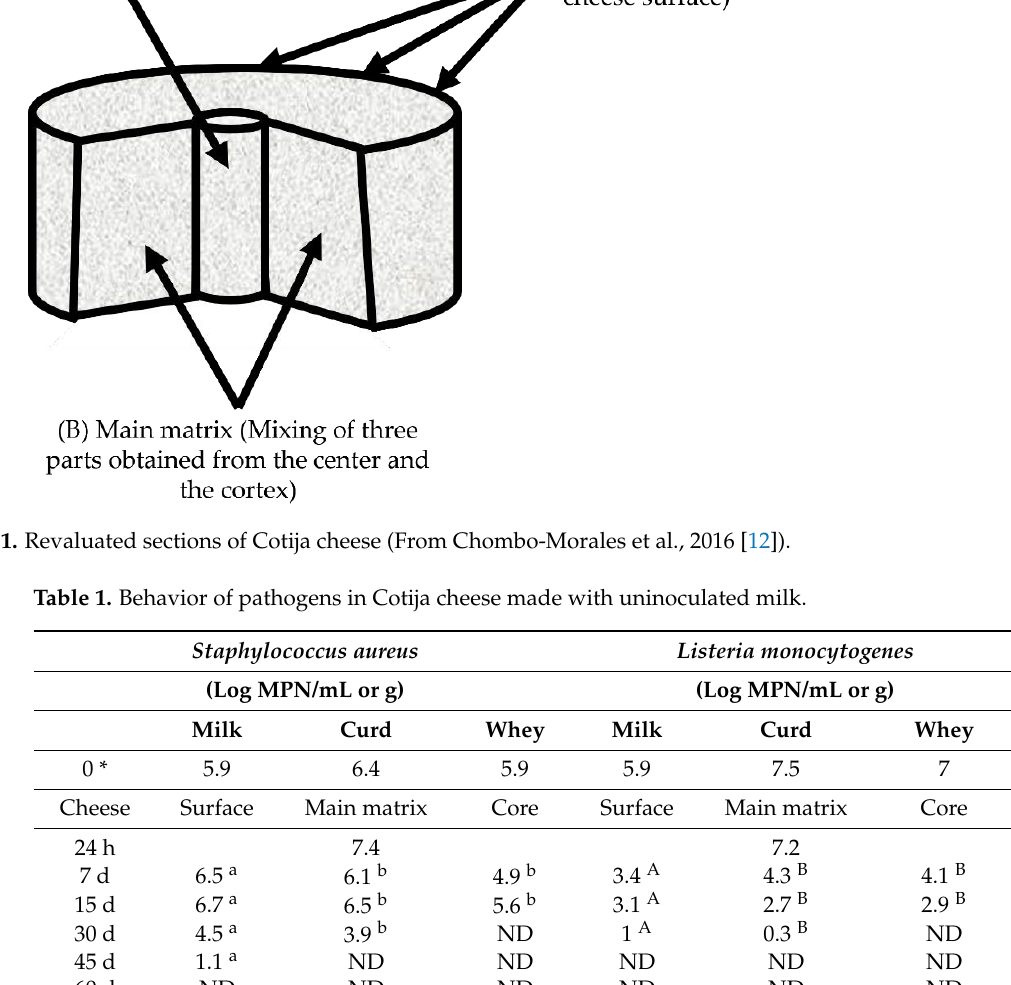
Table 1. Behavior of pathogens in Cotija cheese made with uninoculated milk. Staphylococcus aureus Listeria monocytogenes (Log MPN/mL or g)